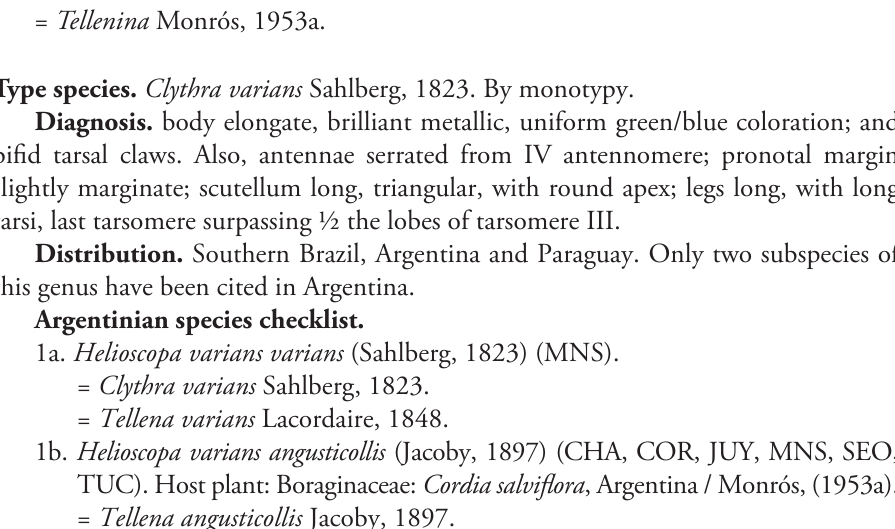
Figure 8. Dinophthalma amplicollis Monrós (2) , left: habitus (dorsal view), right: habitus (lateral view). = Tellena Lacordaire,